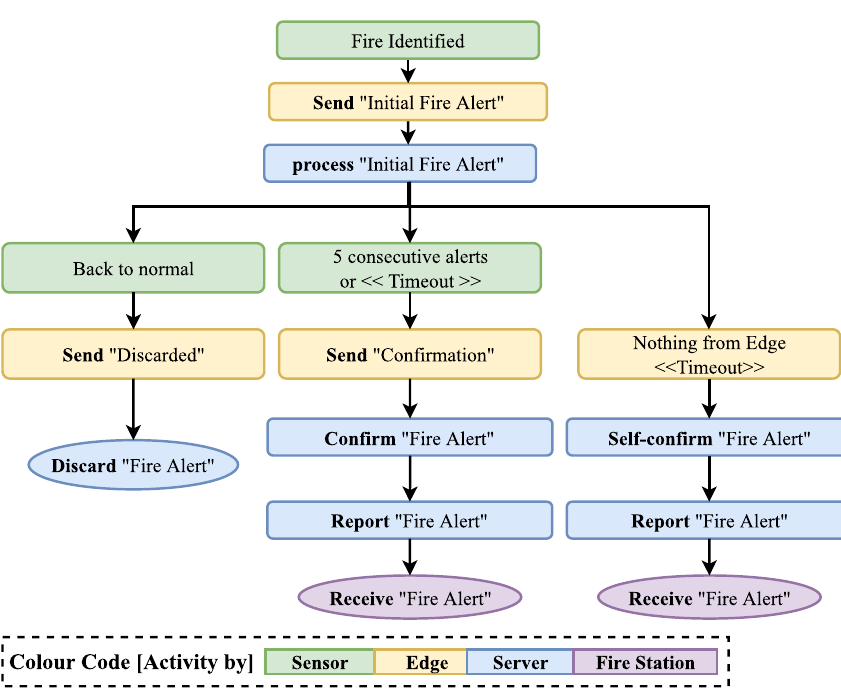
Fig. 7 key stages for a fire event across different IoT